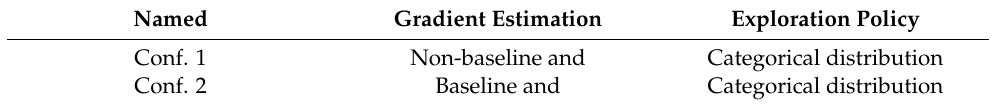
Table 1. Policy gradient configurations implemented. Named Gradient Estimation Exploration Policy Conf. 1 Non-baseline and Categorical distribution Conf. 2 Baseline and Categorical